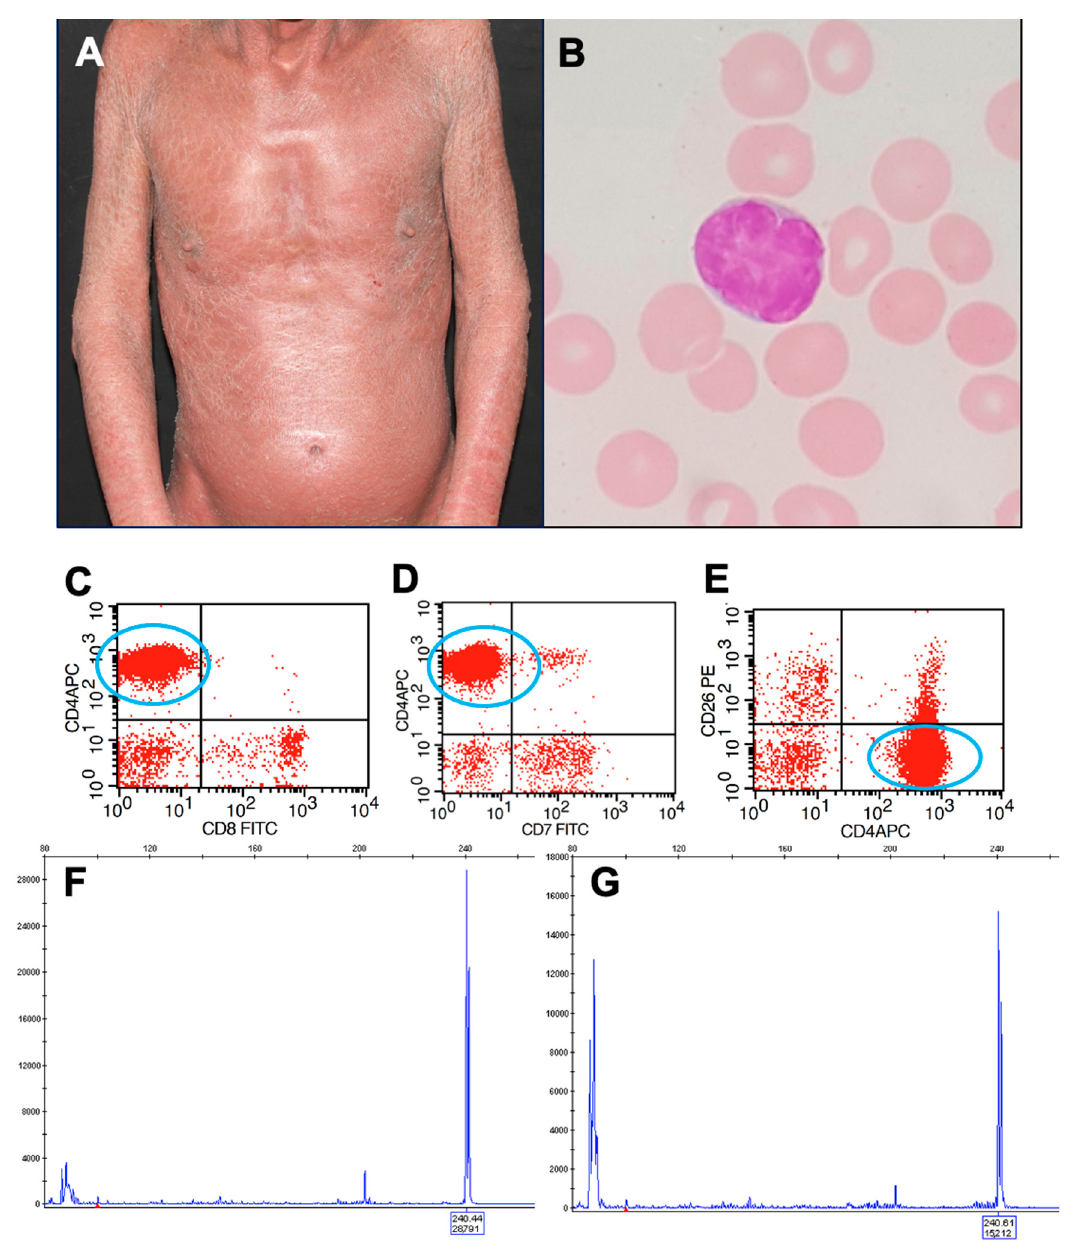
Figure 1. S é zary syndrome. Erythroderma ( A ). S é zary cell on a peripheral blood smear ( B ). Flow cytometry of peripheral blood showing the CD4+CD8 − ( C ), CD4+CD7 − ( D ), and CD4+CD26 − ( E ) S é zary cells. Monoclonal T-cell population on the skin ( F ) and the same clone detected on peripheral blood ( G